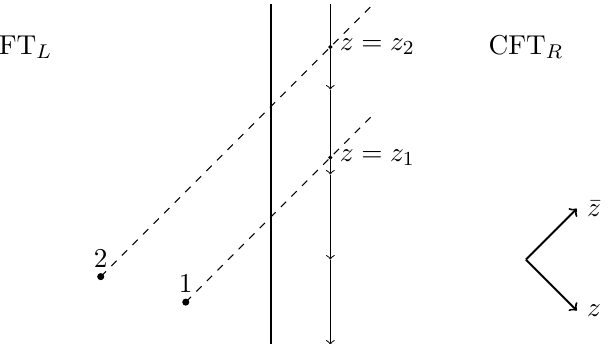
Figure 8 . The arrows mark the path of the operator T R ( z ), at (cid:12)xed z 1 ; (cid:22) z 1 ; z 2 ; (cid:22) z 2 . Due to holo- morphy, the path can be freely deformed in the (cid:22) z direction. The marked points along the path, at z = z 1 and z = z 2 , are the Landau singularities listed in table 1.